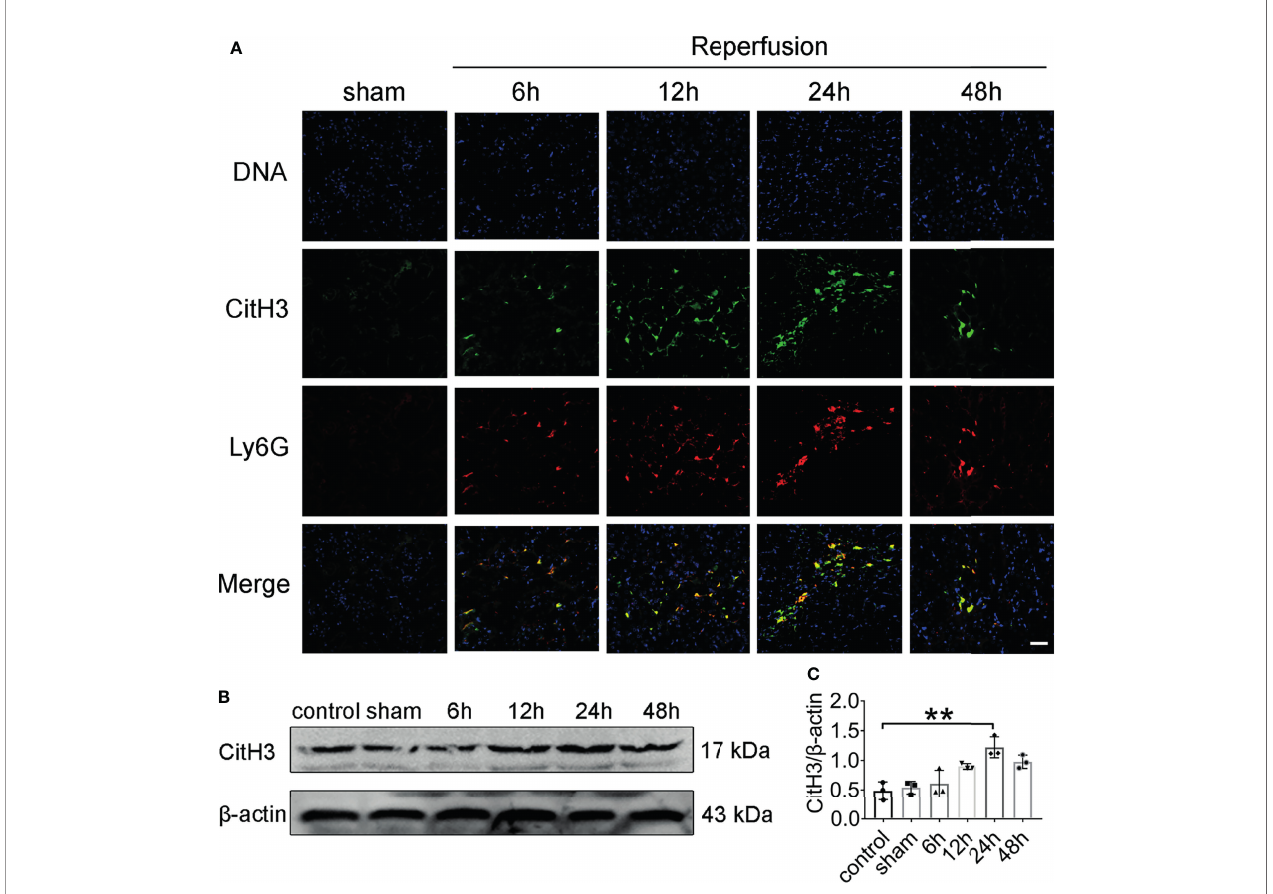
FIGURE 2 | NET formation in the mouse kidney after acute injury. (A) Representative NETs staining of bilateral IRI at different time points after reperfusion. Colocalization of CitH3 (green), Ly6G (red), and swelled nuclei (blue). (B) CitH3 (expected weight: 17 kDa) expression in bilateral IRI kidneys by immunoblotting. (C) Quantitative analysis was analyzed by normalization to b -actin expression, n = 3/group. **P < 0.01. Data are presented as mean ±